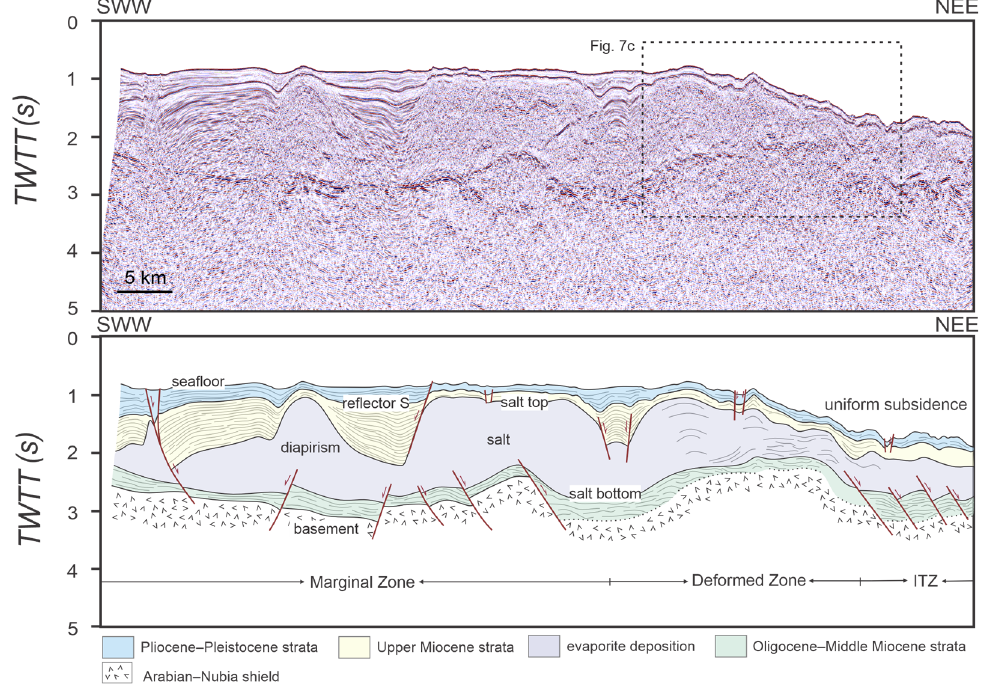
Figure 6. Re fl ection seismic pro fi le 050 and interpretations. Dashed box shows the area of Figure